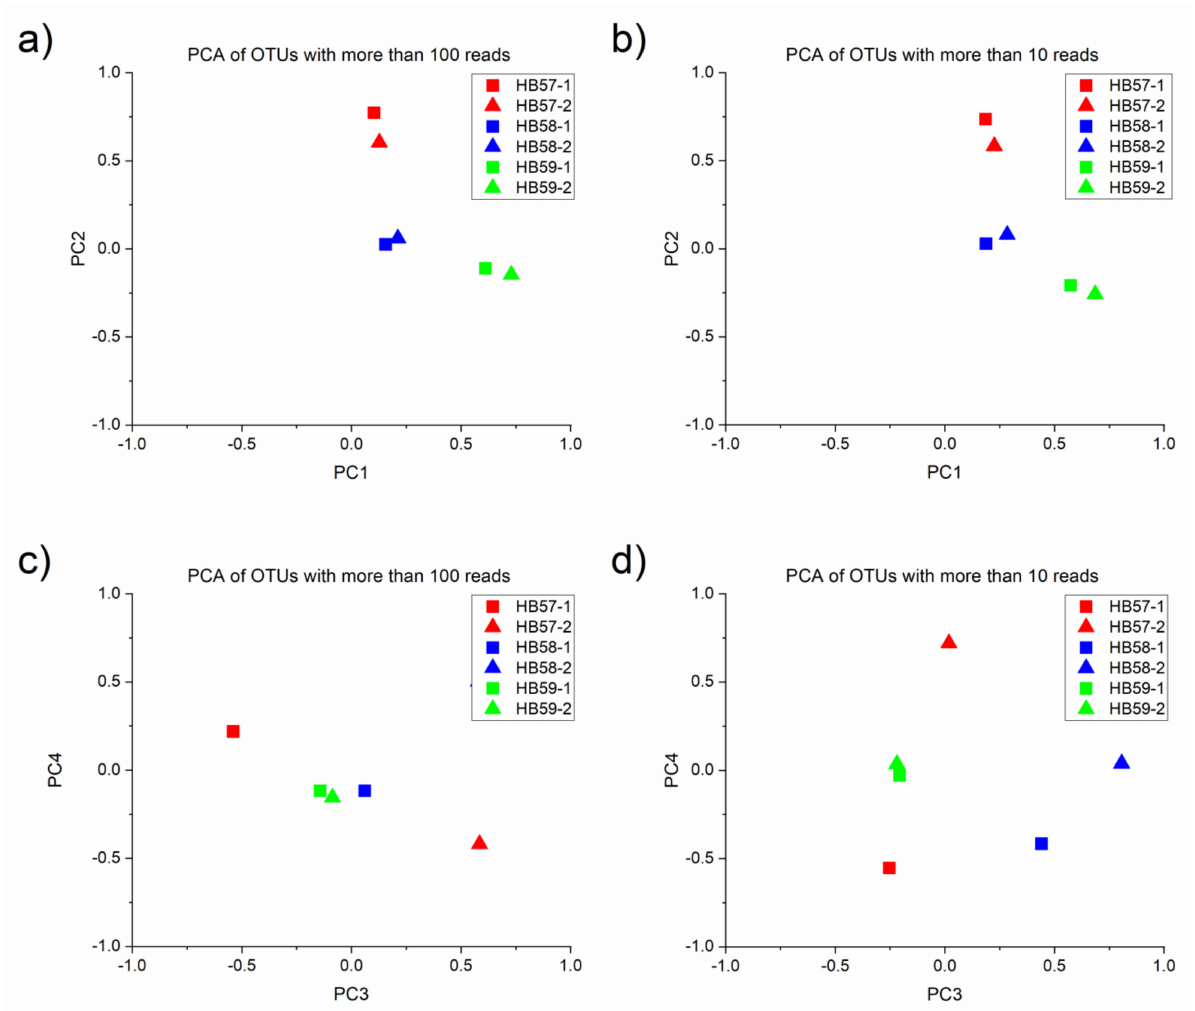
Figure 10. PCA for the six investigated samples, HB57-1, HB57-2, HB58-1, HB58-2, HP59-1, andHB59- 2, from the three sampling sites (topsoil, coal seam, and shaft-filling sediment). The PCA data are shown for the sets of OTUs with more than 10 and more than 100 reads: ( a ) plot of first and second principle component for OTUs with more than 100 reads, ( b ) plot of first and second principle component for OTUs with more than 10 reads, ( c ) plot of third and fourth principle component for OTUs with more than 100 reads, ( d ) plot of third and fourth principle component for OTUs with more than 10